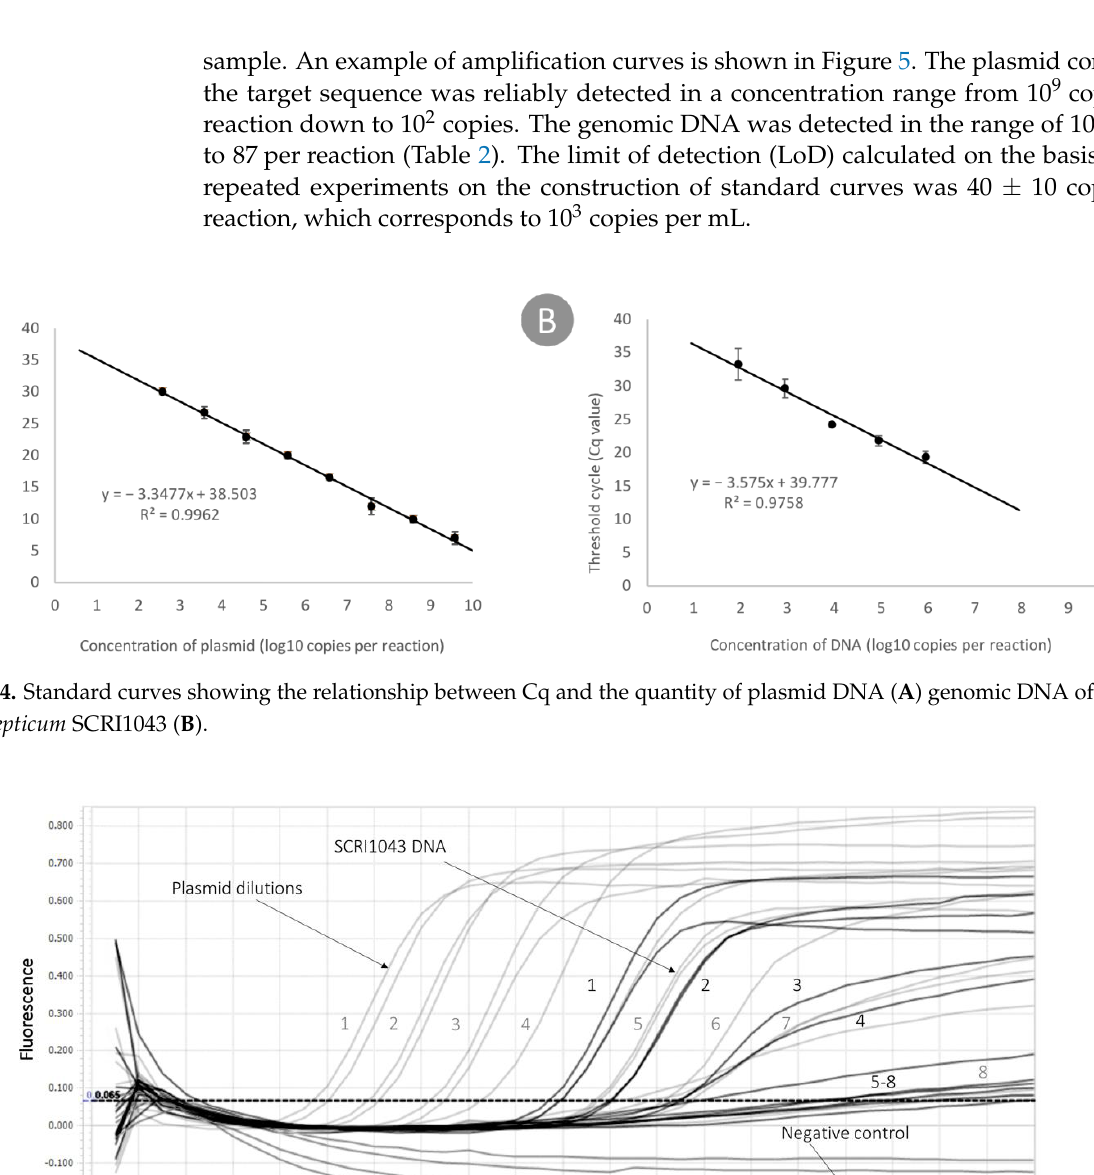
Table 2. Mean C q values for qPCR carried out on serial dilutions of genomic DNA of the P. atrosep- 212